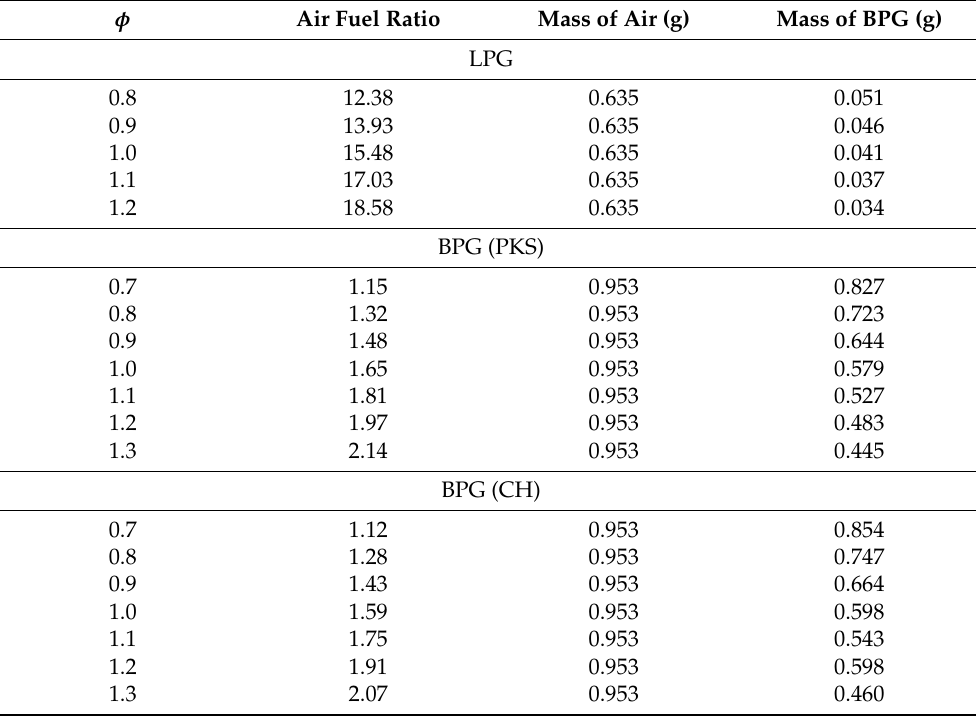
Table 2. The calculation of the mass of air and BPG under various φ